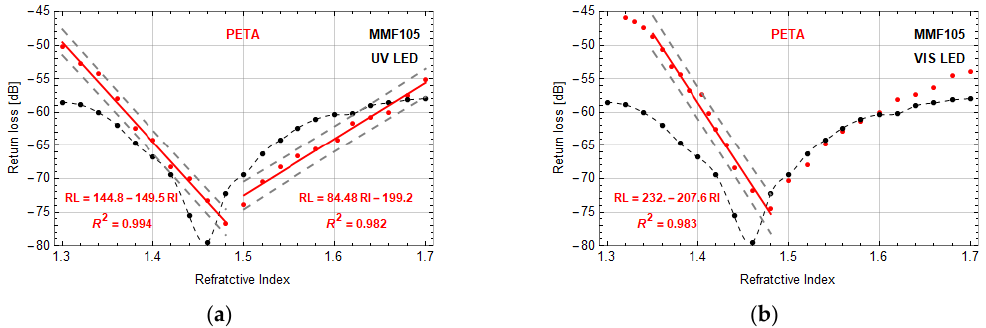
Figure 7. Return loss vs. RI—microtip manufactured by using UV LED on MMF200 based on polymer: ( a ) PETA—microtip size: 200 ± 1 µm base diameter, ( b ) TCDMA—microtip size: 196 ± 1 µm base diameter. Manufacturing parameters: optical power—500 μW and exposition time—30 s. Red and blue lines are linear approximations of measurement points with presented equations and coefficient of determination R 2 . Black dots are reference measurements of the return loss of MMF200 without microtip.